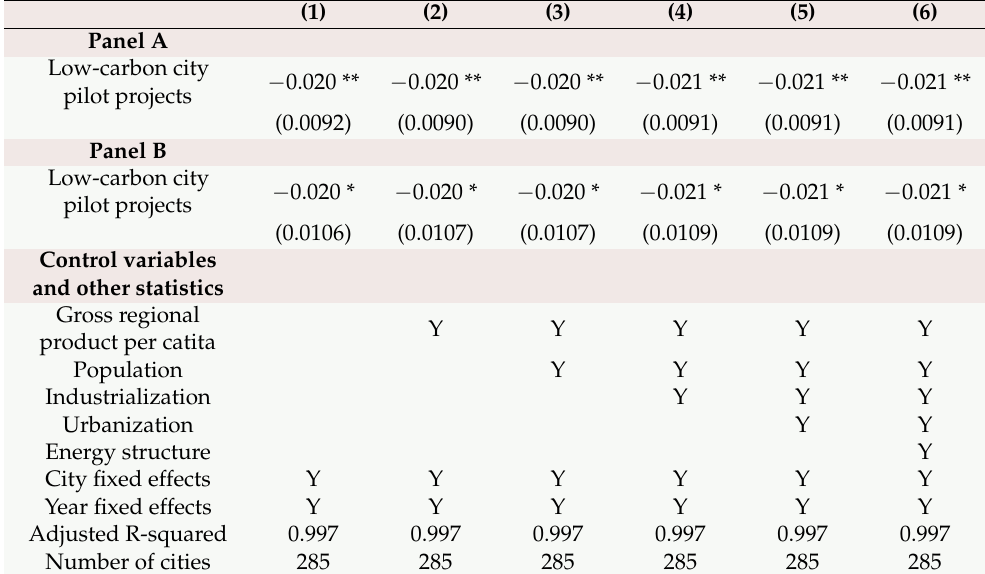
Table 3. Estimates in the impact on carbon from inverse-probability-weighting difference-in- differences